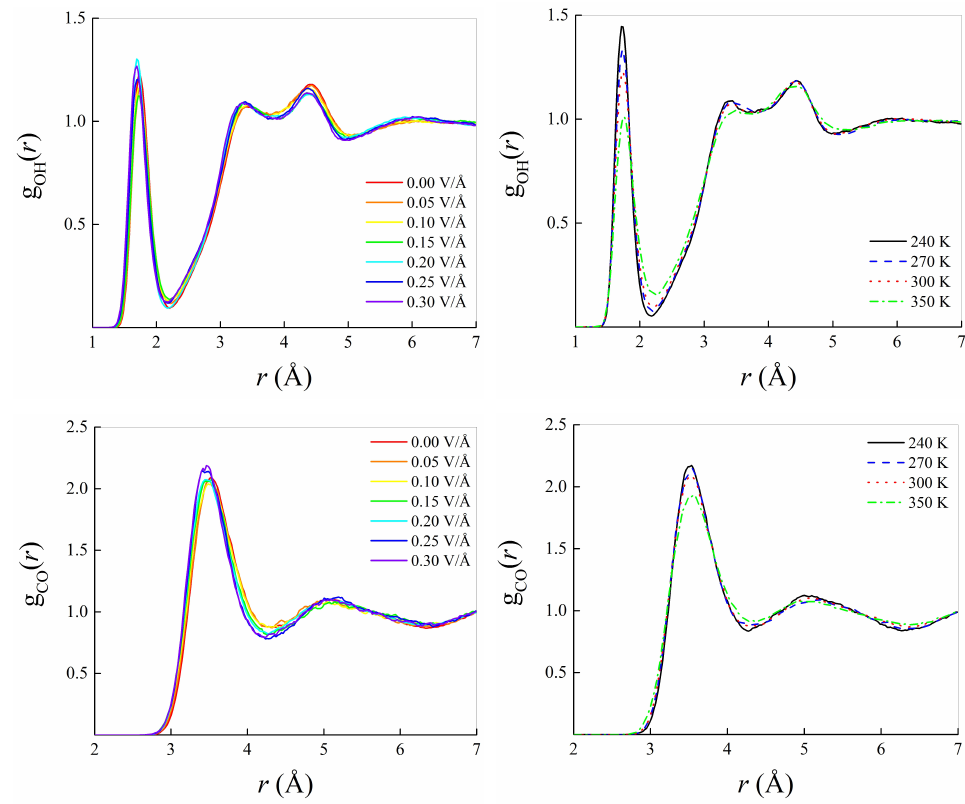
Figure 8. Intermolecular oxygen–oxygen ( top ), oxygen–hydrogen ( center ), and carbon–oxygen ( bottom ) radial distribution functions (RDFs) in bulk neat methanol at different field strengths and at room temperature ( left ) and in the zero-field case and for different values of the temperature ( right